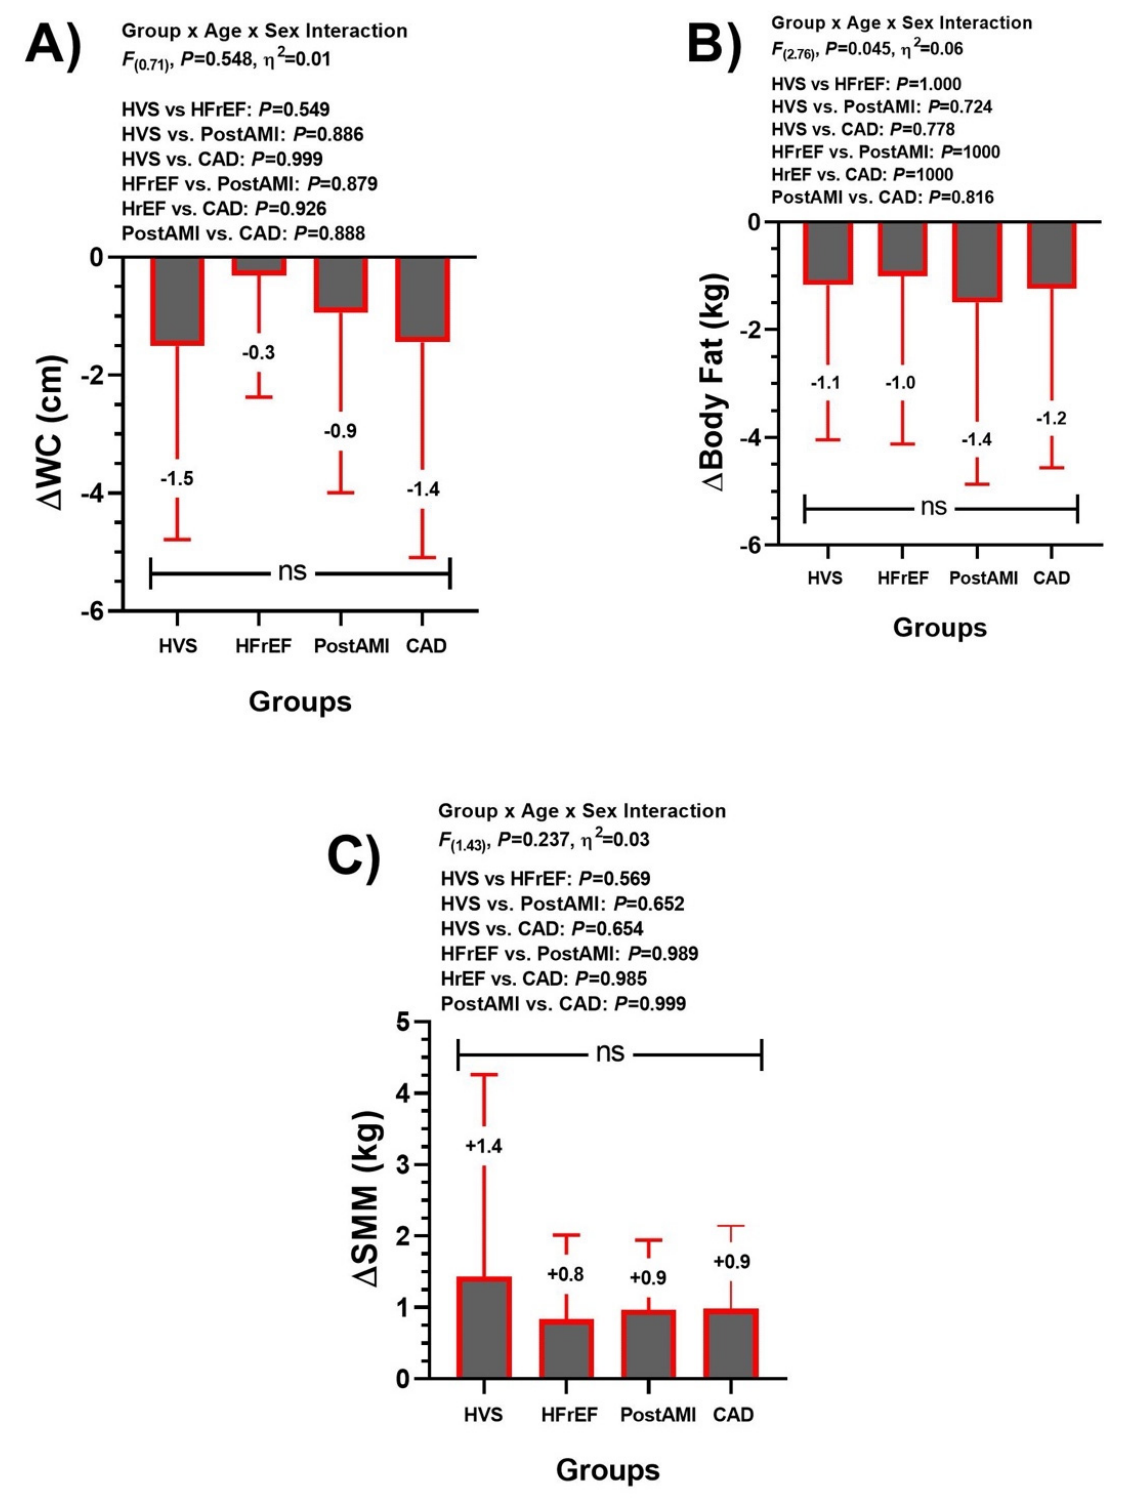
Figure 1. Delta changes ( ∆ ) from pre-post calculation in anthropometric/body composition outcomes (panel ( A ) [WC] waist circumference, panel ( B ) [body fat], and panel ( C ) [SMM] skeletal muscle mass) after a comprehensive outpatient cardiovascular rehabilitation program in heart valve surgery (HVS), heart failure with reduced ejection fraction (HFrEF), post-acute myocardial infarction (post-AMI), and coronary artery disease (CAD) patients. Non-significant (ns) changes among groups.